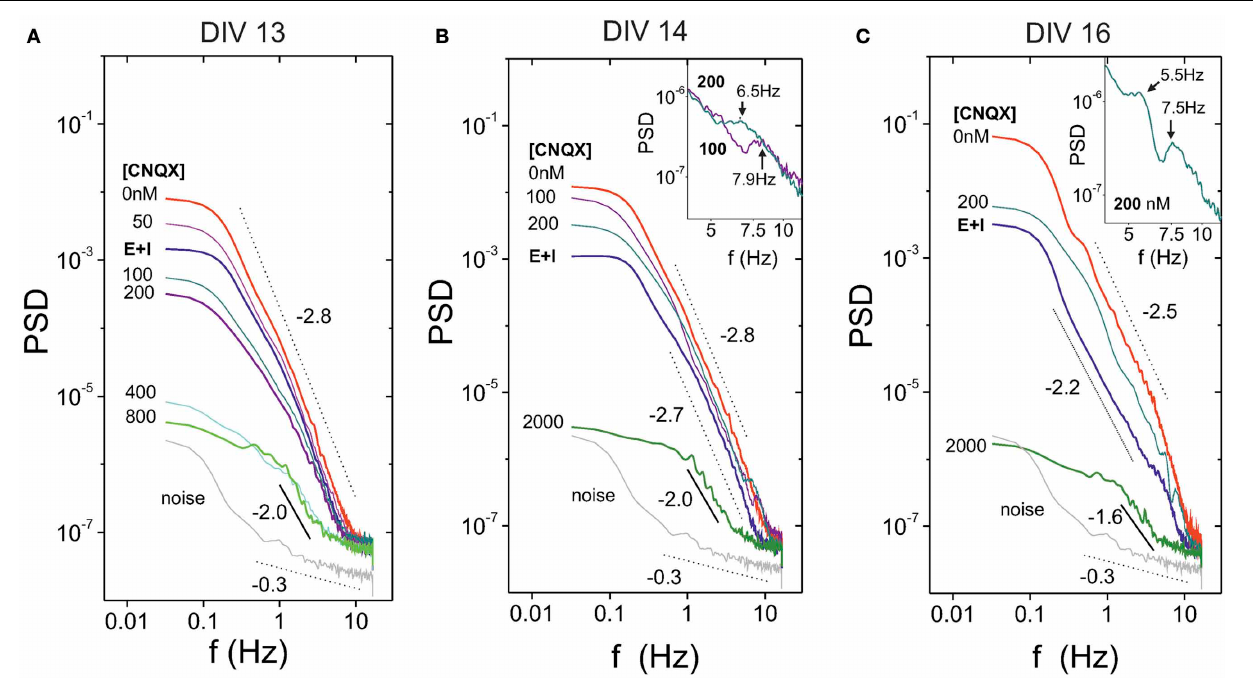
FIGURE 6 | Power spectrum density (PSD) in mature cultures during network disintegration through CNQX. (A) General trend of the PSD for a culture at DIV 13. For [ CNQX ] = 0 the PSD exhibits its highest energy, which is associated to the high amplitude of the bursting episodes. The PSD energy gradually decreases with CNQX, and for [CNQX] (cid:4) 800nM bursting is absent and the PSD reveals temporal correlations arising from individual neuronal